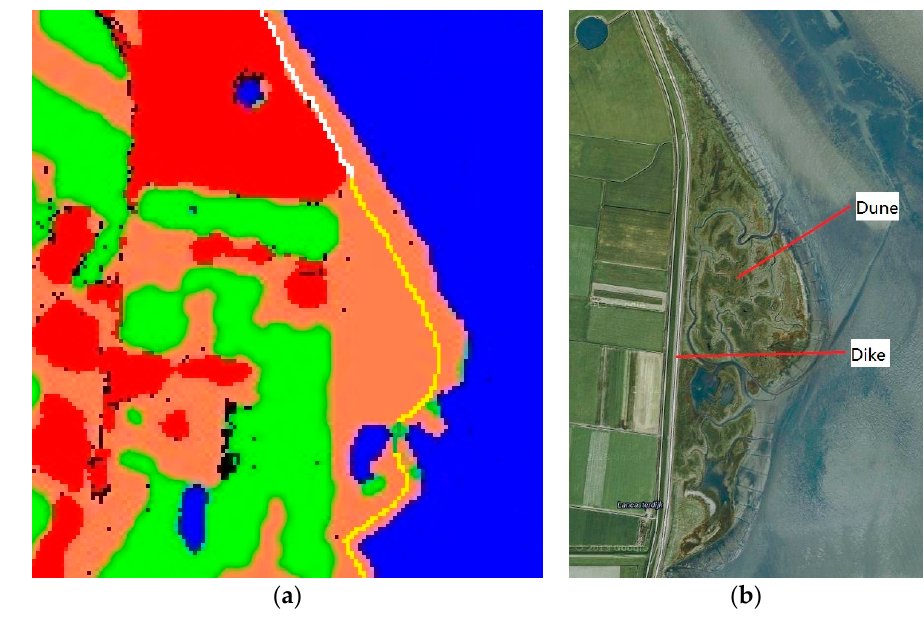
Figure 13. ( a ) Misclassification of dike line; ( b ) A dike behind a developing dune.